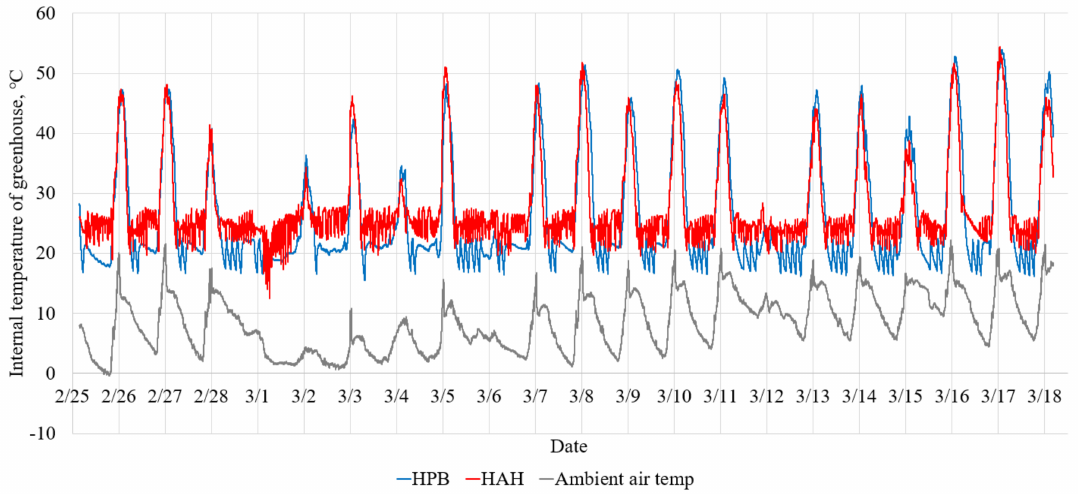
Figure 9. Comparison of heating test results for greenhouses using HPB and HAH.